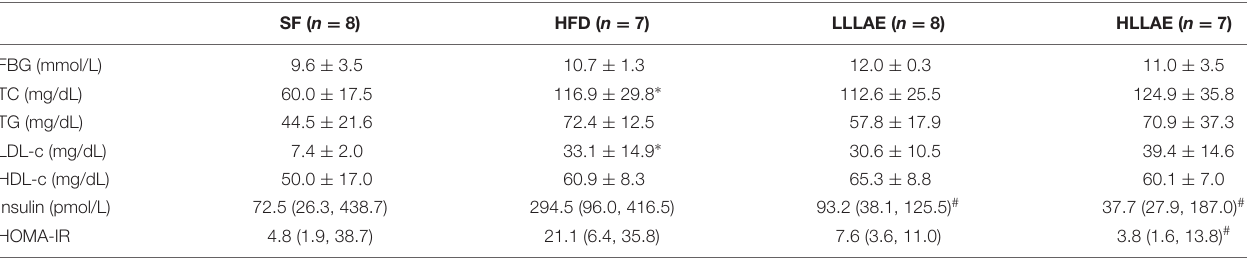
TABLE 1 | Effects of LLAE on biochemical parameters, insulin and HOMA-IR in HFD-induced obese rats (cid:49)